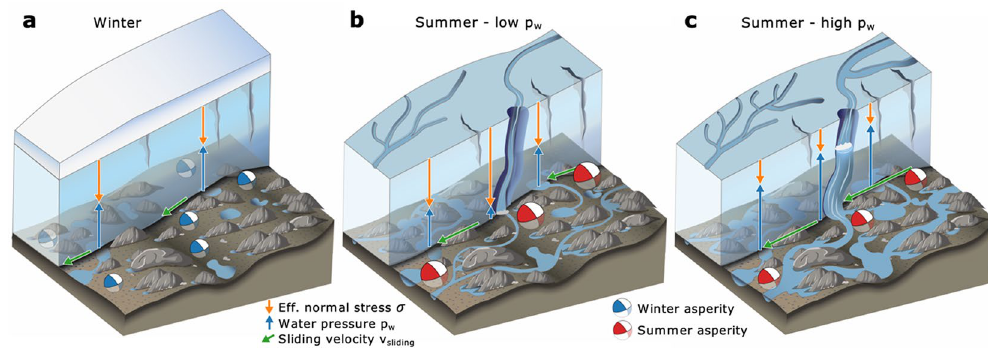
Figure 4. Conceptual model of subglacial hydraulic system and asperities therein. ( a ) Subglacial environment in winter. Isolated cavities dominate the subglacial hydraulic system. Sliding velocity is low and effective normal stresses and stick–slip asperities are evenly distributed over the bed ( b ) Summer conditions during phases with low basal water pressure. Linked cavities have opened up and constitute the non-efficient subglacial drainage system that enables high sliding velocities even during low water pressures in channels. Stick–slip asperities develop close to these channels and release high moments. ( c ) Similar to b, but with high basal water pressures resulting in high sliding velocities and less moment released at stick–slip asperities compared to summer conditions with low water pressures shown in panel